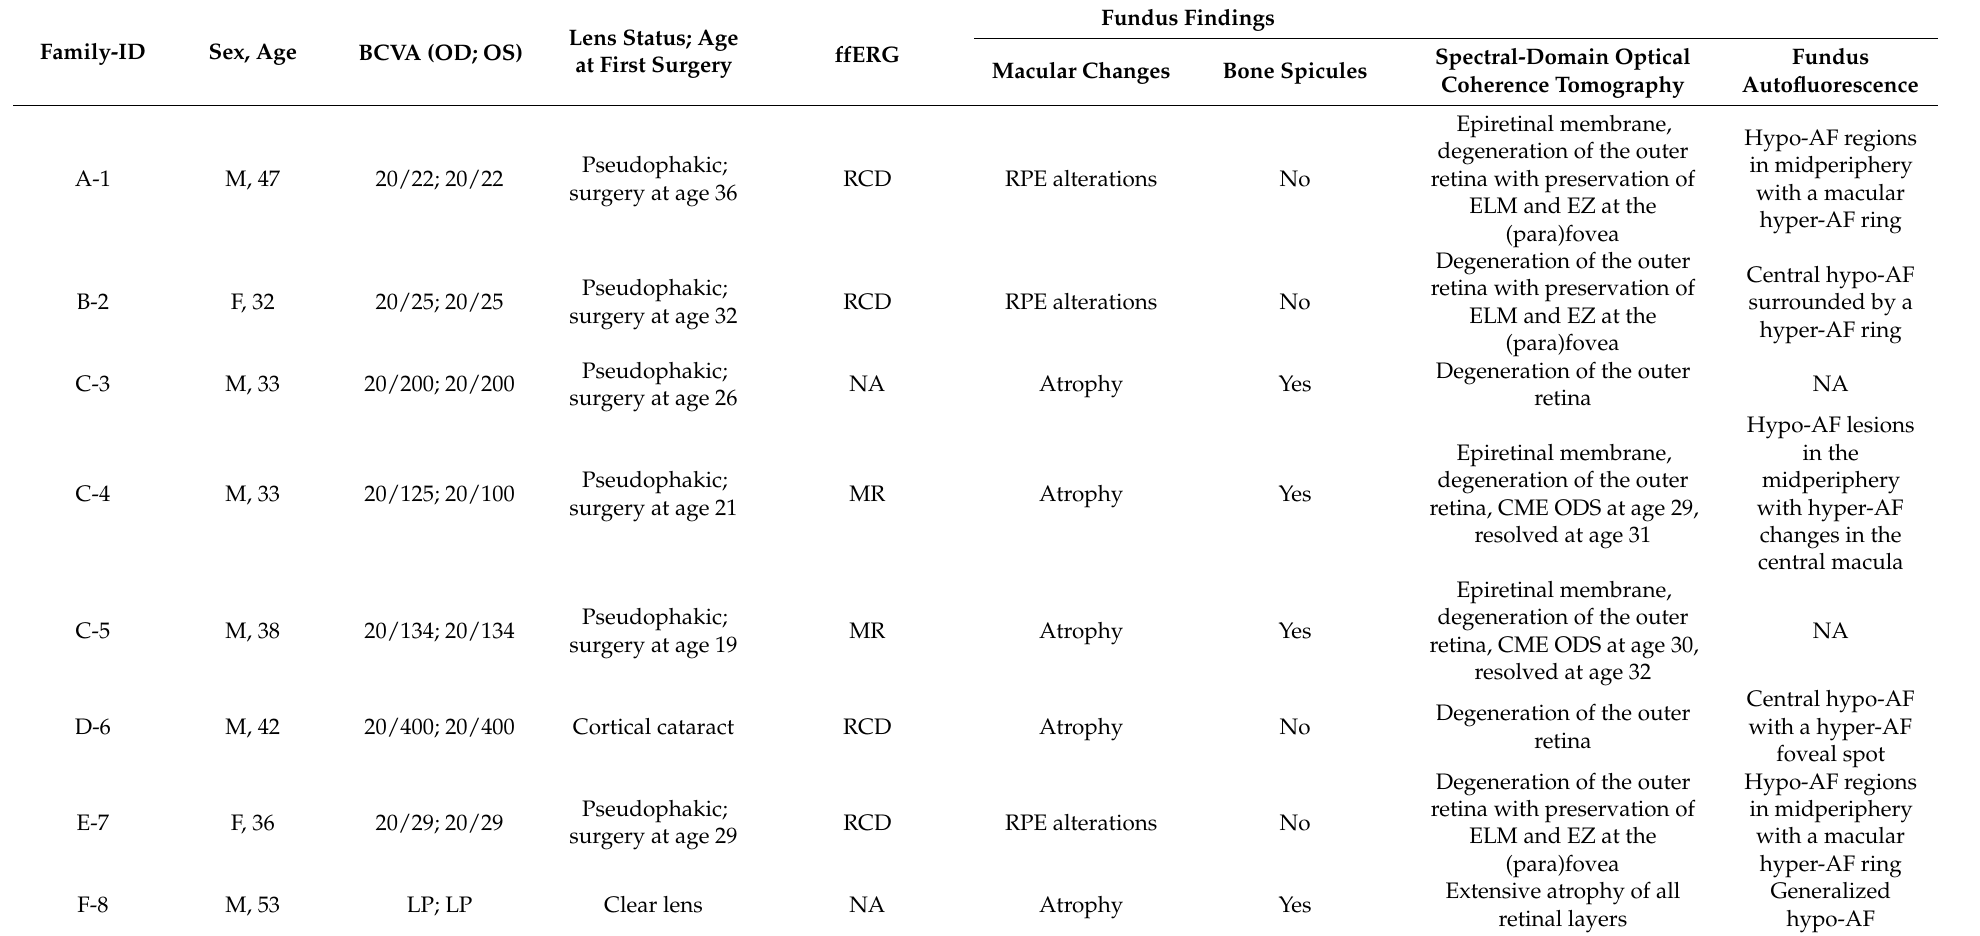
Table 2. Summary of ophthalmic findings at the most recent examination in this cohort of patients with biallelic ABHD12